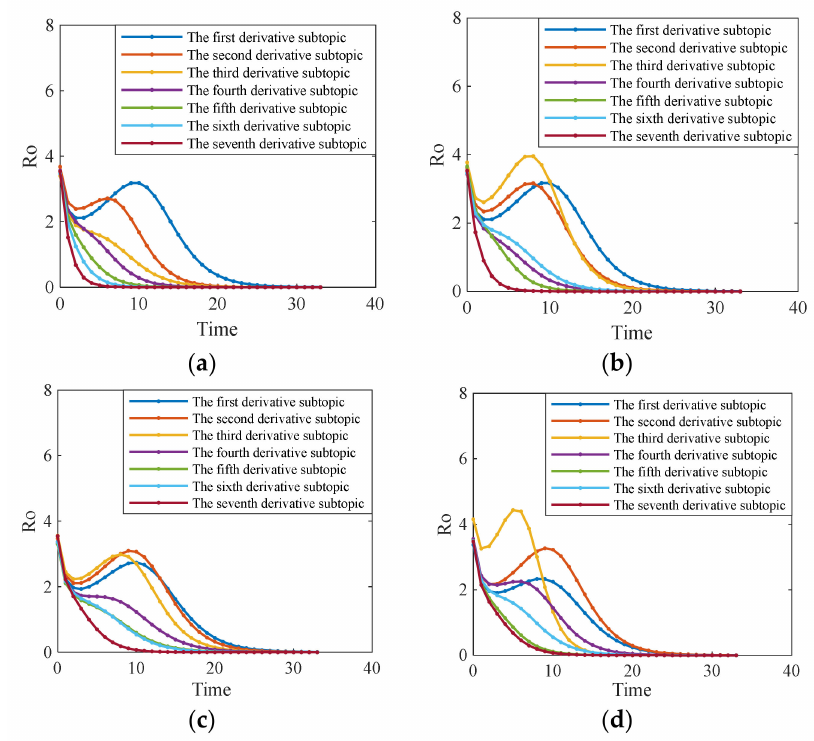
Figure 20. The change of R 0 under different distributions of correlation. ( a ) θ ~N (0.3, 0.3).